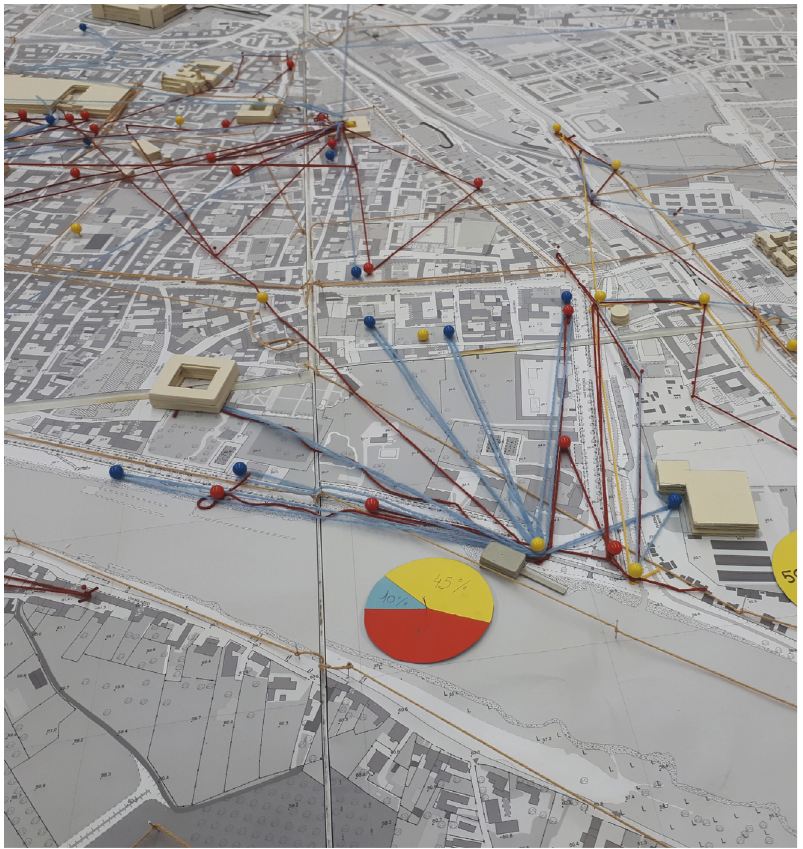
Picture of the mapping performed on the physical model of Pavia. Detail from the south-east part of the town centre, between the Collegio Borromeo and the Idroscalo (image by the